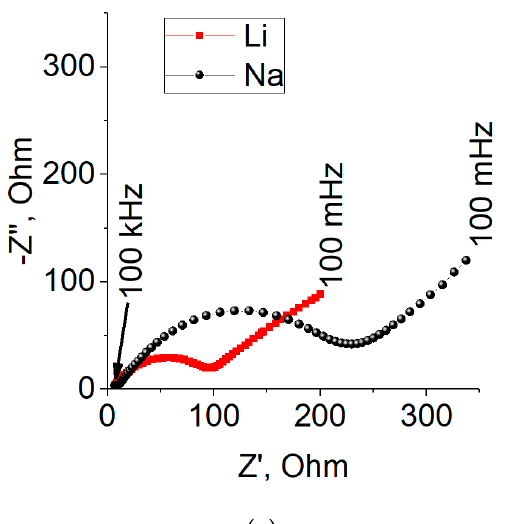
Figure 5. ( a ) CVs for sodium insertion/extraction into/from CoGe 2 P 0.1 at two scan rates; ( b ) charge and discharge curves for sodium insertion/extraction at various current densities.